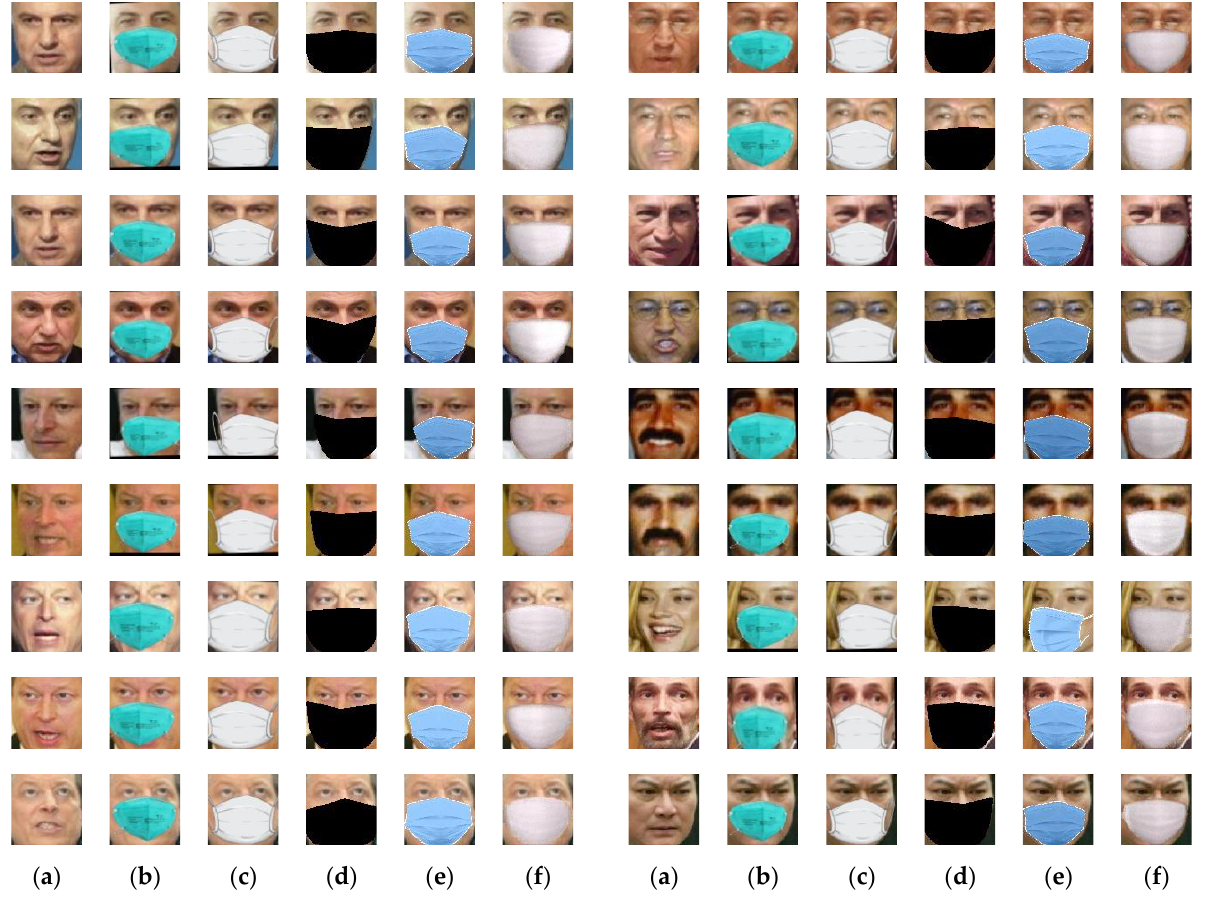
Figure 10. Comparison results on LFW database. ( a ) Input. ( b ) Method in [12]. ( c ) Method in [12]. ( d ) Method in [16]. ( e ) Method in [17]. ( f ) Proposed